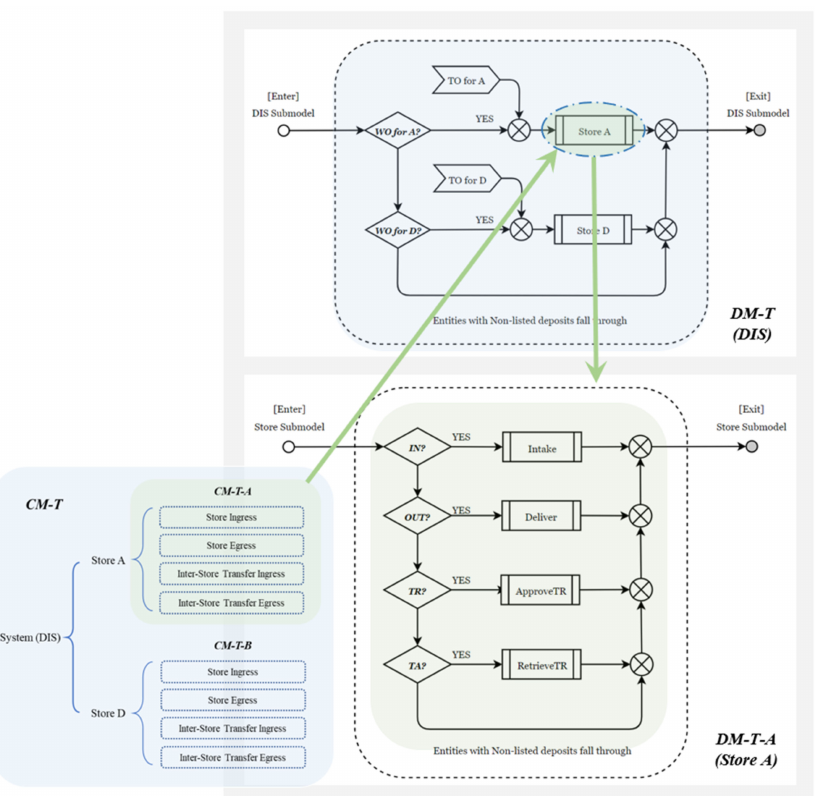
Figure 21. Conversion of CM-T (detailed in Figure 18) to Design Model—Tactical planes. Main plane (DM-T) highlighted in blue and sub-plane DM-T-A in green.